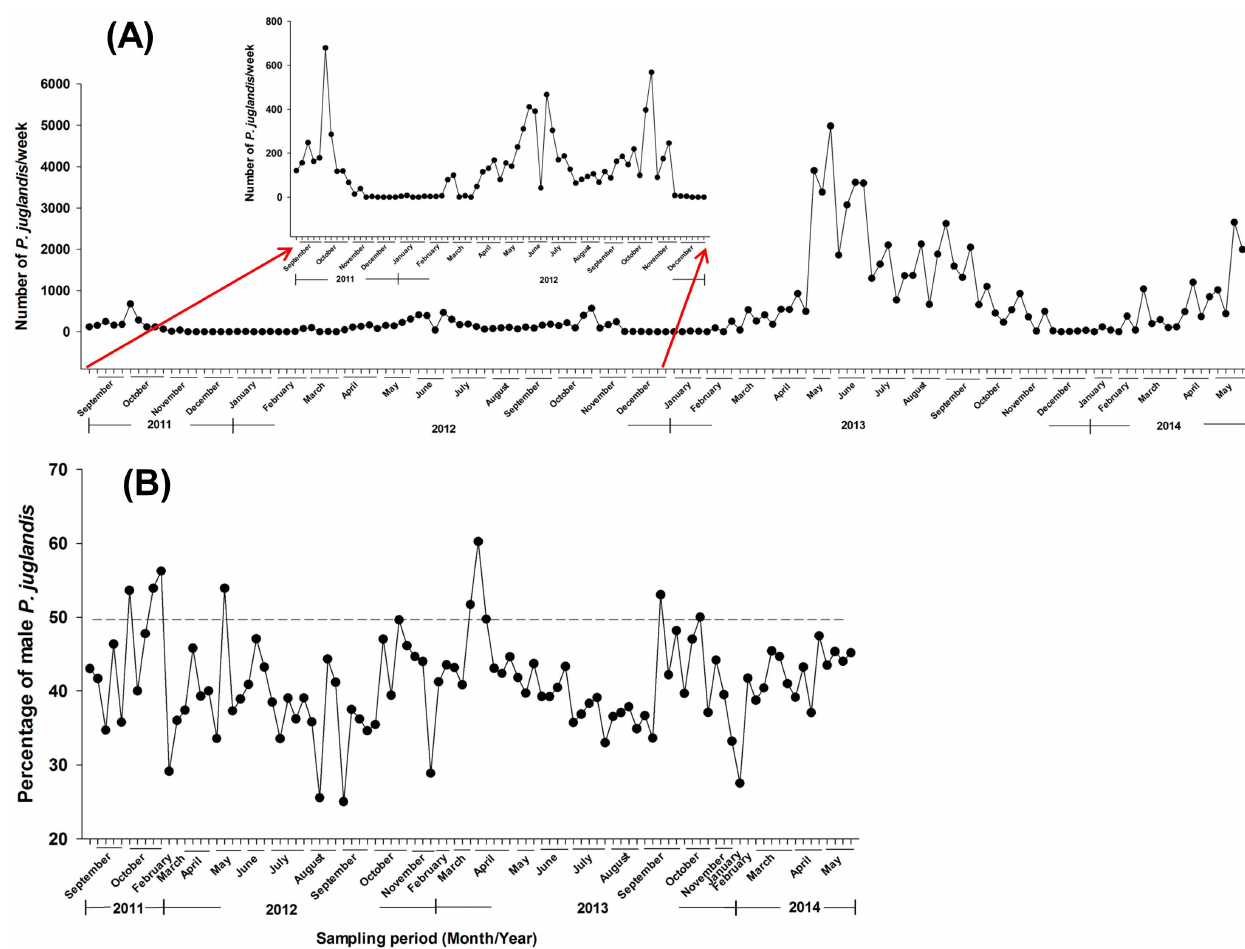
Figure 1. Weekly Pityophthorusjuglandis total trap catches (A) and percentage of males in selected catches (B) from 29 August, 2011 to 2 June, 2014 in five Lindgren funnel traps. Hash marks along the x-axis denote the first day of each week. Percentages of males are presented for weeks when more than 50 P. juglandis were trapped. Inset in (A): rescaling of weekly P. juglandis catches from 29 August, 2011 to 31 December, 2012 to facilitate comparison of seasonal flight pattern with 2013 and 2014 when flight responses were higher.